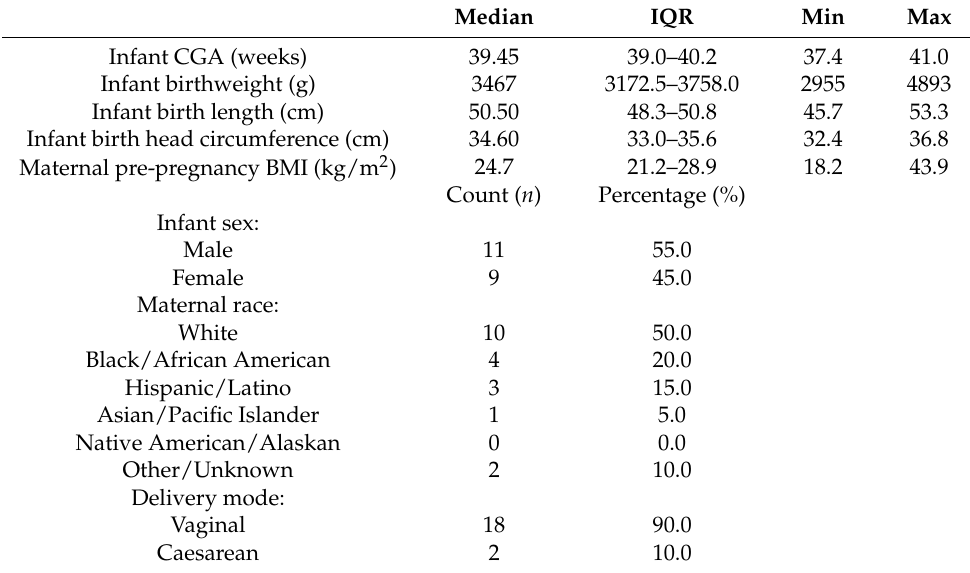
Table 1. Demographic Data of Mother–Infant Dyads.